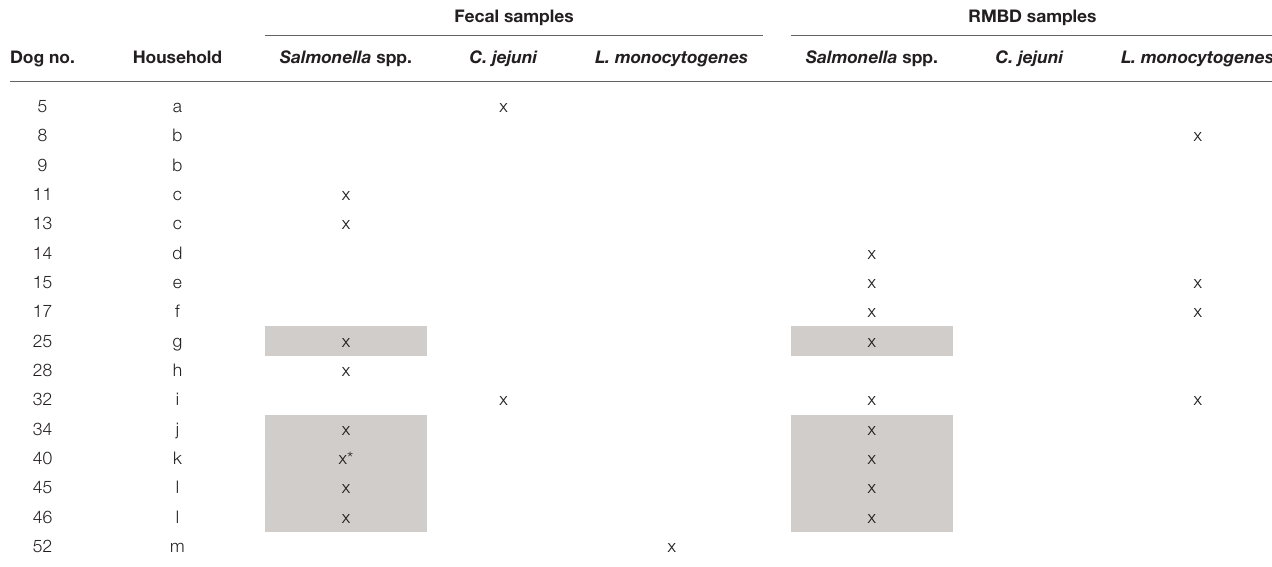
TABLE 2 | Analysis of the co-occurrence between isolates from pet food consumed by dog participants ( n = 11) and the pathogen dog carriers ( n = 11). Fecal samples RMBD samples Dog no. Household Salmonella spp. C. jejuni L. monocytogenes Salmonella spp. C. jejuni L. monocytogenes